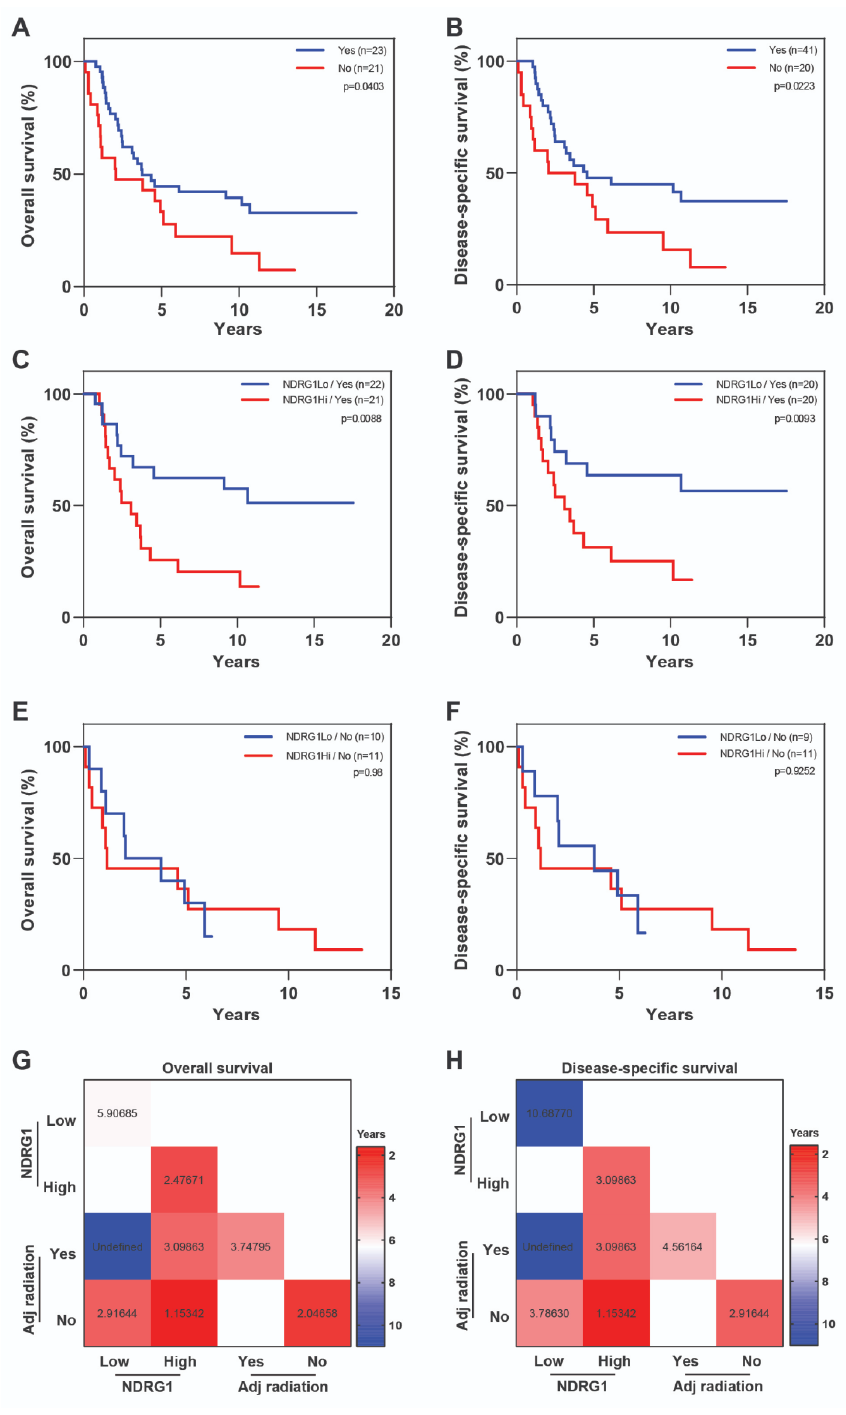
Figure 5. High NDRG1 expression correlated with worse outcomes among patients who received adjuvant radiation therapy. IBC patients who received adjuvant radiation had better ( A ) overall survival ( B ) and disease-specific survival than did patients who did not receive radiation. ( C , D ) Patients who received adjuvant radiation treatment stratified by NDRG1 expression in terms of overall survival and disease-specific survival. ( E , F ) Patients who did not receive adjuvant radiation stratified by NDRG1 expression in terms of overall survival and disease-specific survival. Log-rank tests were used to obtain p values. ( G , H ) Median overall survival and disease-specific survival times, in years, for patients stratified by NDRG1 expression and adjuvant radiation treatment